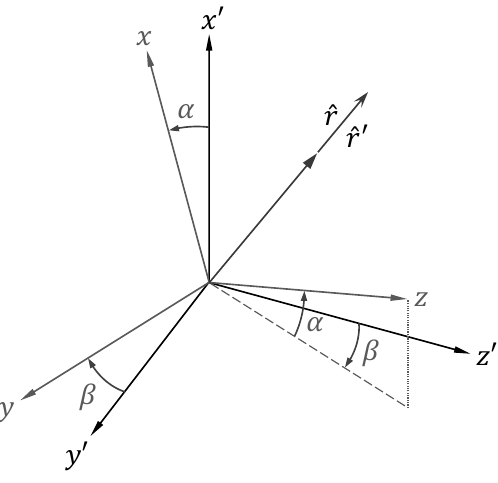
Figure 3. Coordinate systems attached to the antenna array ( xyz ) and to the ground ( x (cid:48) y (cid:48) z (cid:48) ). The unit vectors ˆ x (cid:48) , ˆ y (cid:48) , and ˆ z (cid:48) in the rectangular coordinate system attached to